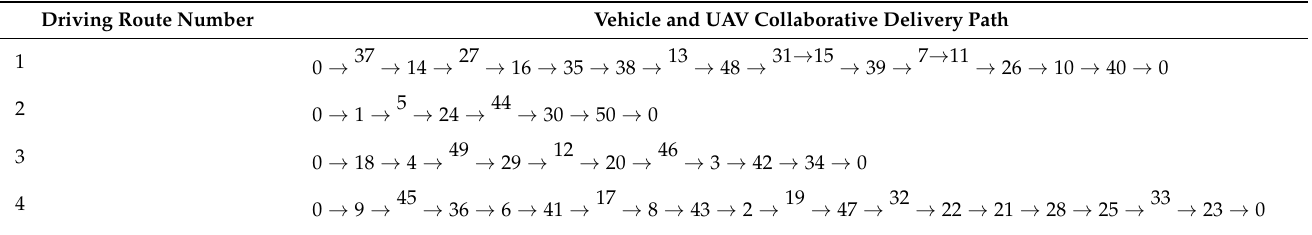
Table 3. The optimal solution for collaborative vehicle and UAV delivery.